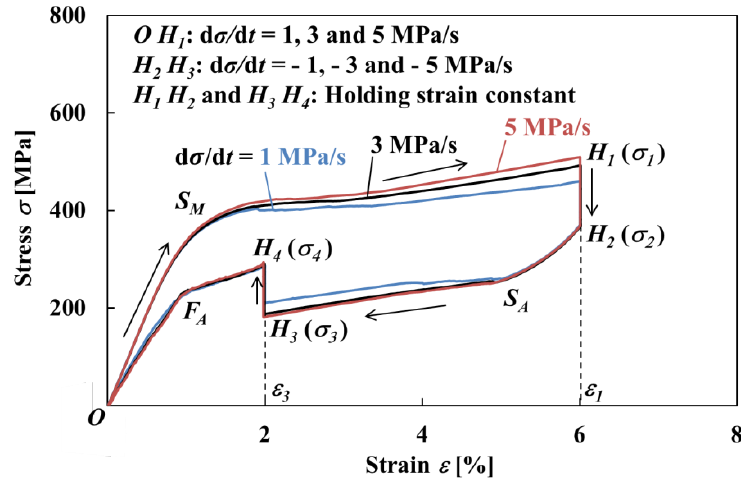
Figure 12. Stress-strain curves obtained by the test under various stress rates dσ/d t until point H followed by holding the strain constant at ε 1 point H followed by holding the strain constant at ε 3